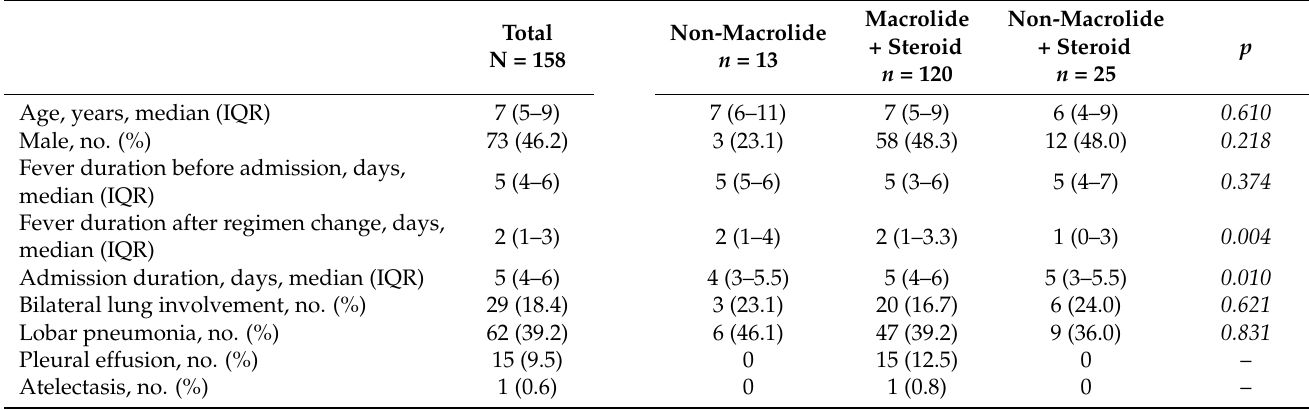
Table 1. Demographic and laboratory data according to treatment groups of patients who were refractory to initial macrolide